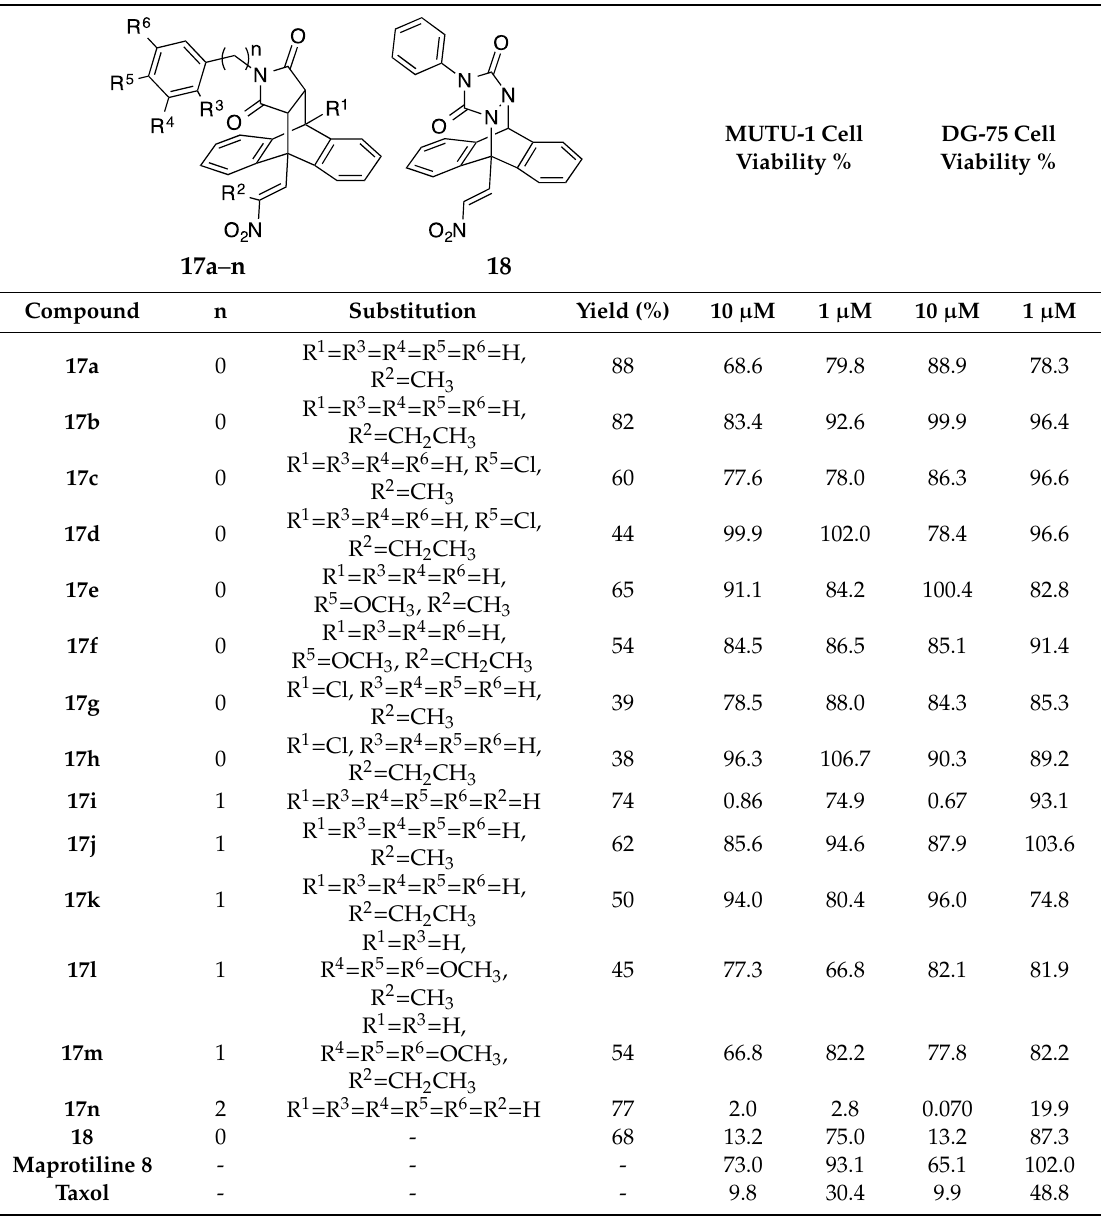
Table 3. Yields and preliminary cell viability data for compounds 17a – n , 18 (Series IIIB) in MUTU-1 and DG-75 Burkitt lymphoma cell lines a .